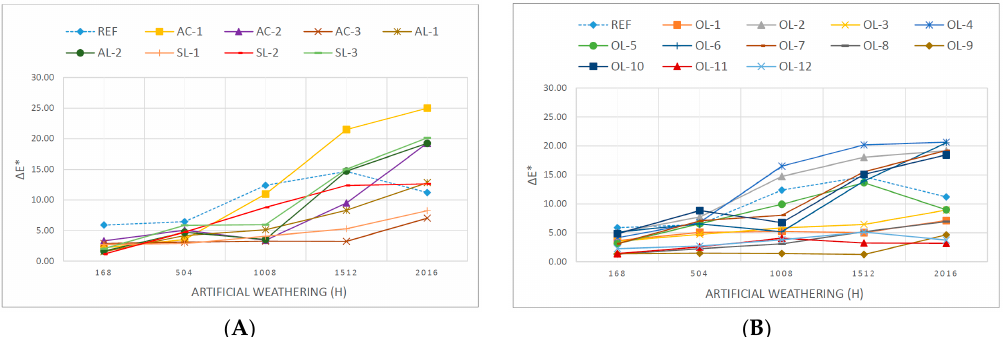
Figure 3. The total colour difference of acrylate, alkyd, synthetic ( A ) and oil-based ( B ) coating systems applied to European larch during artificial weathering lasting 168 h, 504 h, 1512 h and 2016 h.